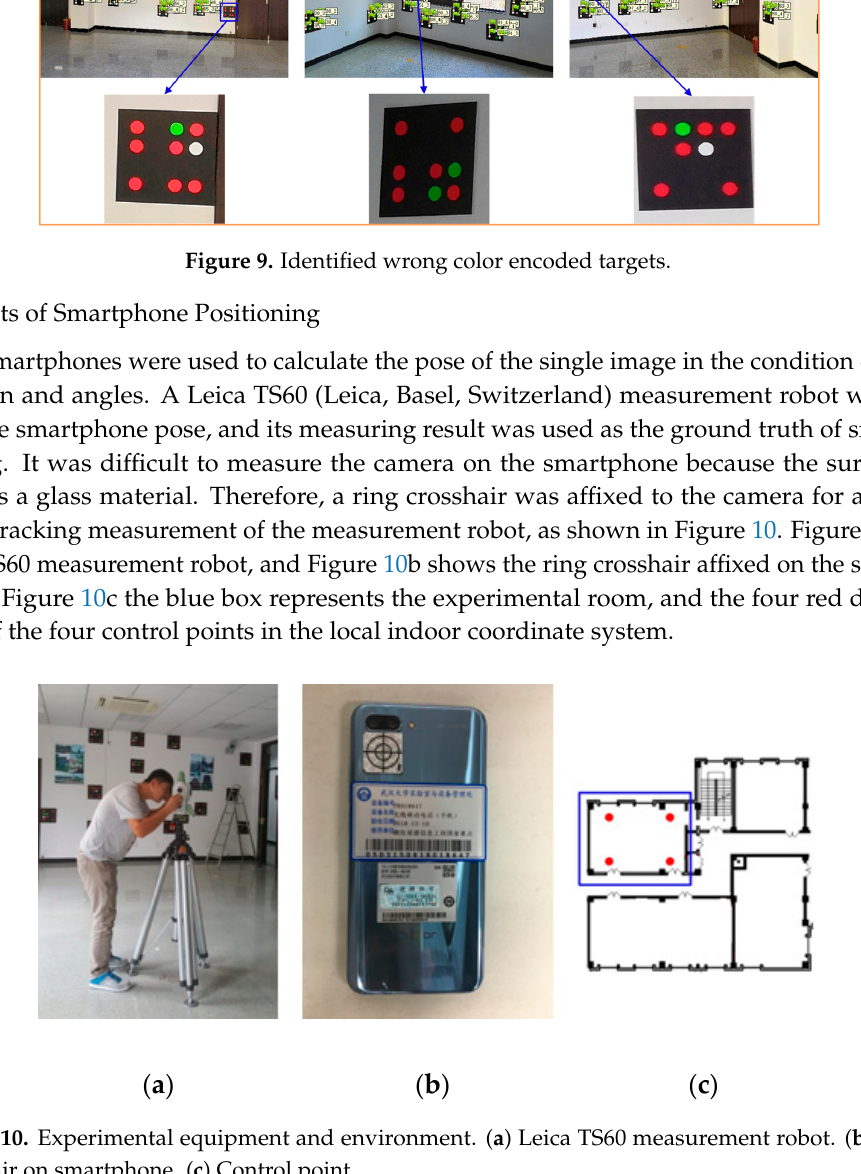
Figure 10. Experimental equipment and environment. ( a ) Leica TS60 measurement robot. ( b ) Ring